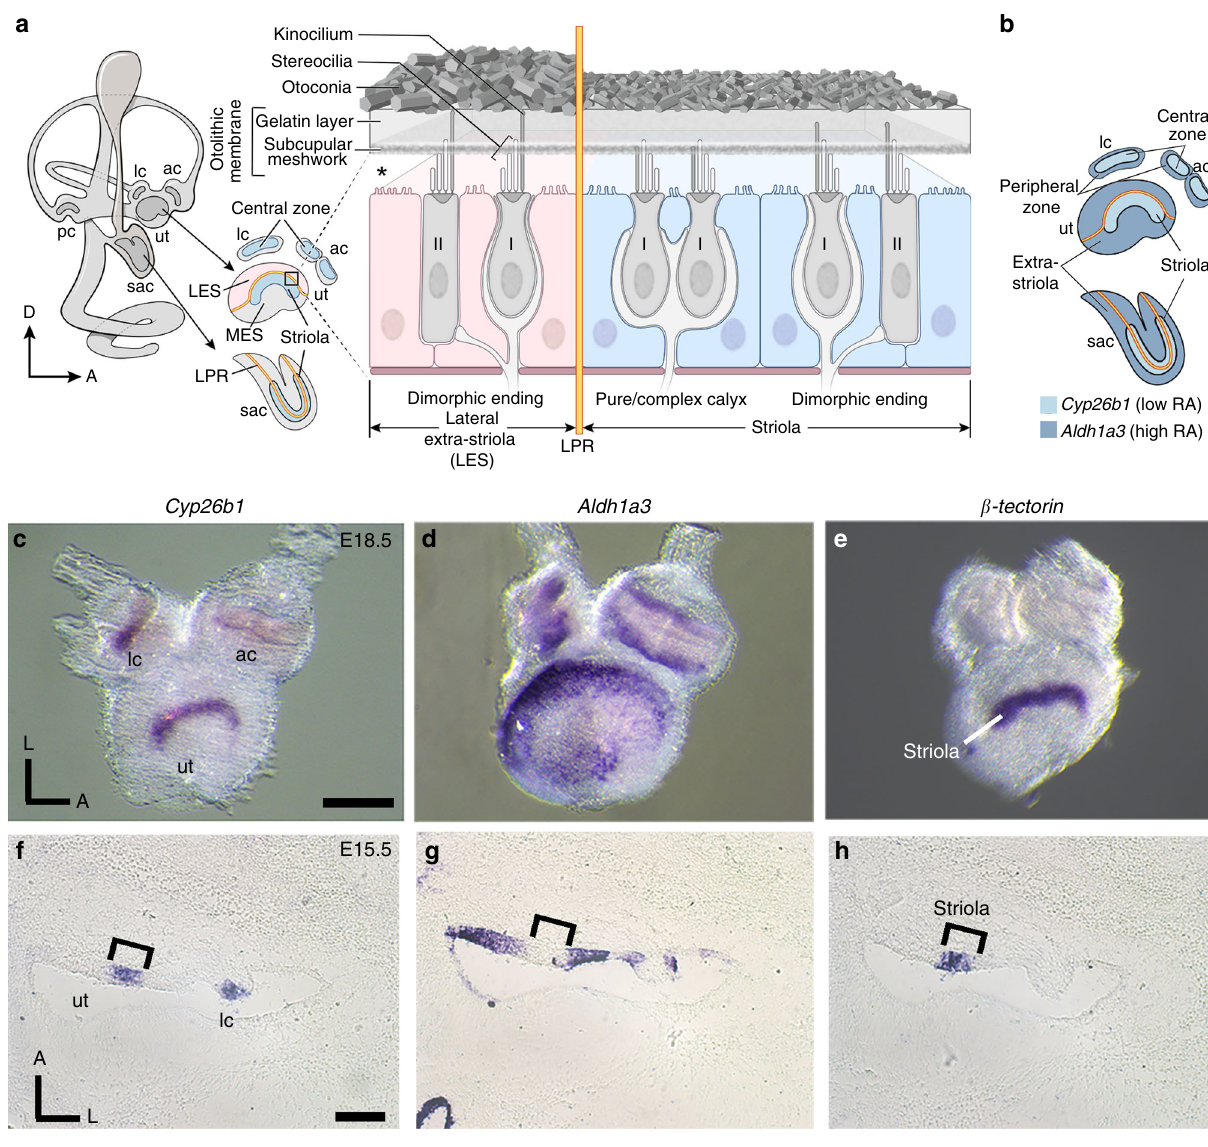
Fig. 1 Complementary expression patterns of Cyp26b1 and Aldh1a3 . a Schematic illustration of the inner ear and sectional view of the utricle (ut) across the striola and lateral extrastriola region (LES). Pear-shaped type I HCs are innervated by calyces and cylindrical-shaped type II HCs are innervated by bouton type endings. Pure/complex calyces are exclusively present in the striolar/central zone, whereas dimorphic nerve endings are found across the entire organ. Otoconia are smaller in size and less abundant in striola than extrastriola of the utricle. Asterisk indicates that the relationship between hair bundles and the otoconial membrane is not clear, but evidence suggests that hair bundles of striolar HCs are less fi rmly embedded in the otolithic membrane than their counterparts in the extrastriolar region 9,84 . Yellow line represents the line of polarity reversal (LPR), which separates each macula into two regions with opposite hair bundle orientations: 1) striola and MES (medial extrastriola): 2) LES. The striola of maculae and the central zone of anterior (ac) and lateral cristae (lc) are in blue color. The LPR is at the lateral edge of the striola in the ut but it bisects the striola in the saccule (sac). b Schematic summary of the expession pattern of Cyp26b1 (light blue) and Aldh1a3 (dark blue) described in c – h . c – e Whole-mount in situ hybridization analysis of Cyp26b1 , Aldh1a3 , and β - tectorin transcripts at E18.5 mouse ut, ac, and lc. Expression of Cyp26b1 ( c ) is restricted to the central zone of the two cristae and striola of the ut that is β - tectorin positive e , whereas Aldh1a3 ( d ) is predominantly expressed in the peripheral regions. f – h Adjacent tissue sections at the levels of ut and lc at E15.5. f Cyp26b1 expression is concentrated in the supporting cell (SC) layer of the central zone of the lc and striola of the ut, comparable to the β -tectorin domain ( h , bracket). g Aldh1a3 expression is largely complementary to Cyp26b1 ( f ) in each organ. Scale bars: 200 μ m. RA, retinoic acid; D, dorsal; A, anterior; L, lateral; pc, posterior crista. a , b Drawn by NIH Medical